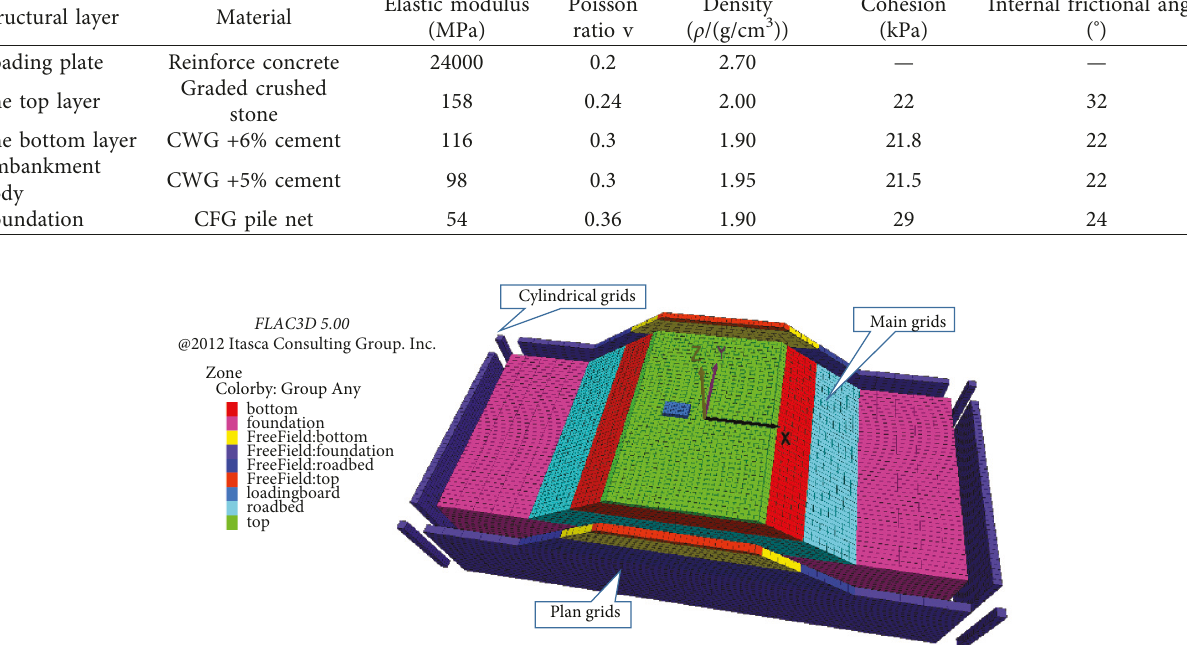
Figure 8: Three-dimensional differential numerical model of the field cyclic loading